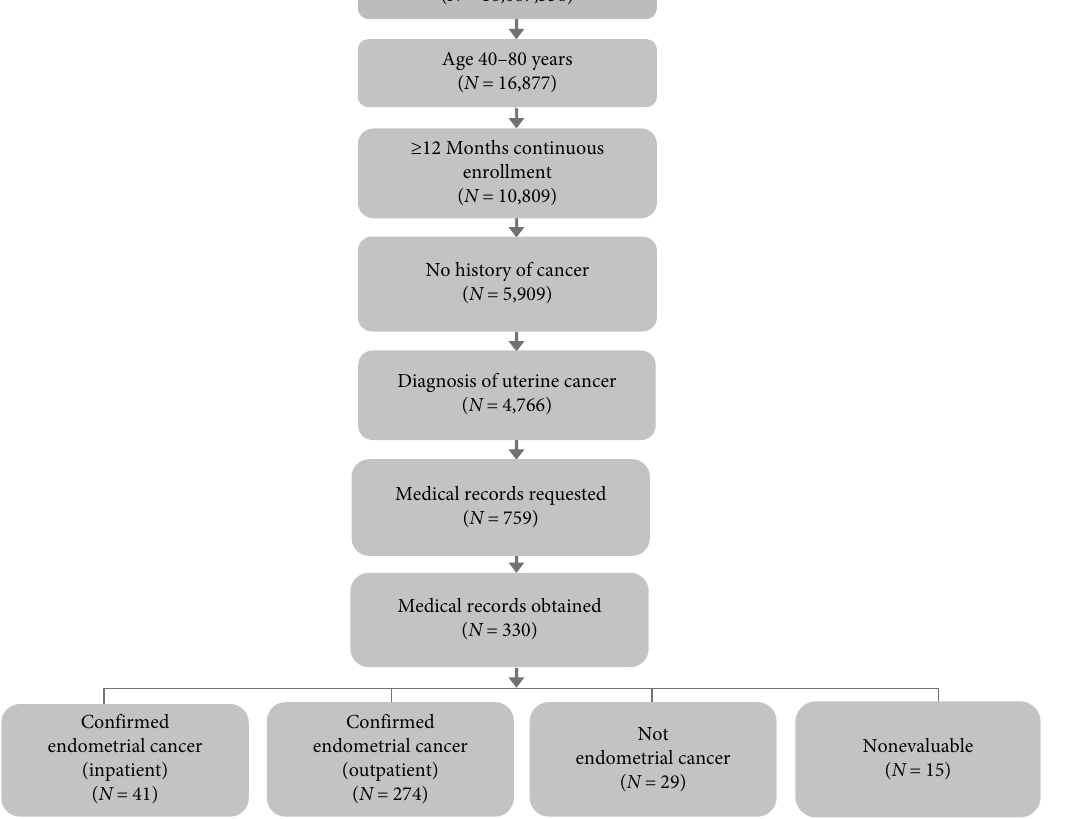
Figure 1: Flowchart of study cohort creation.